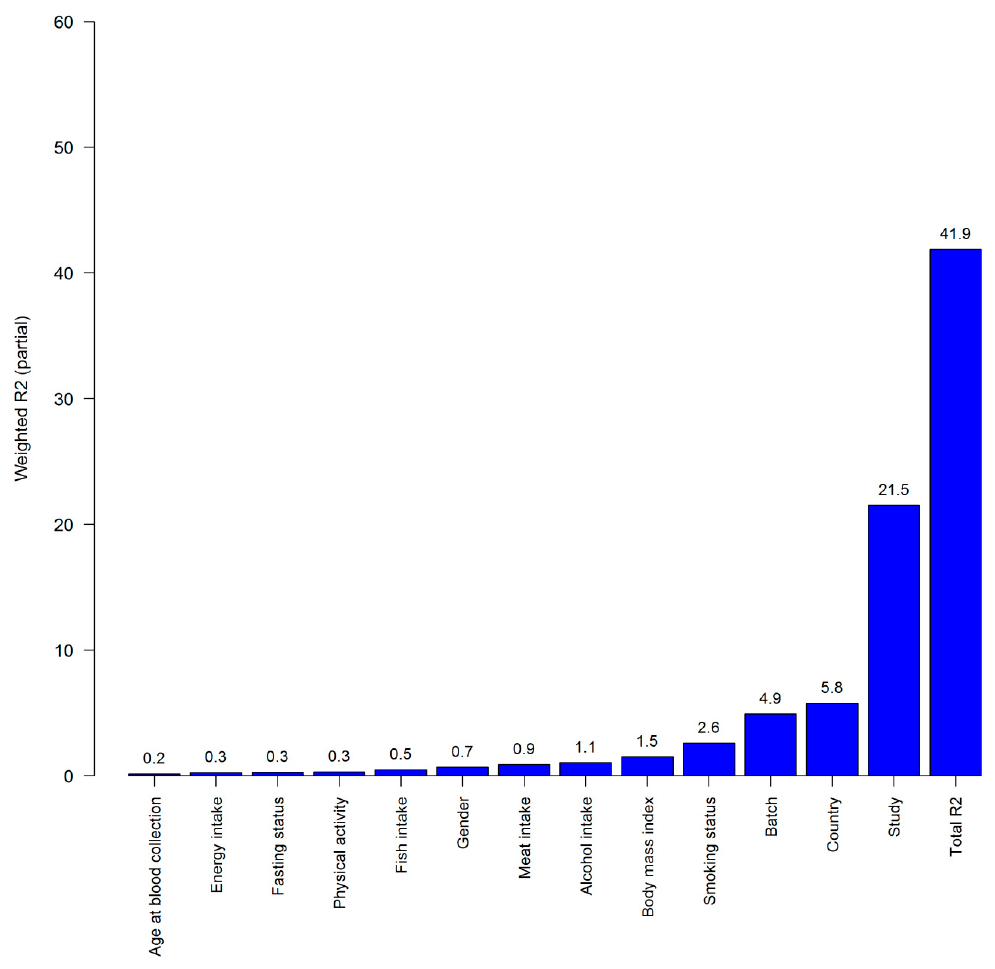
Figure 1. Overall R partial2 and weighted R partial2 for each covariate (sub-study, lifestyle and laboratory variables), indicating the percentage explained variability in metabolite concentrations. Alcohol was included as a log-transformed variable (natural logarithm of continuous alcohol intake + 1) as in the main multivariable analysis.